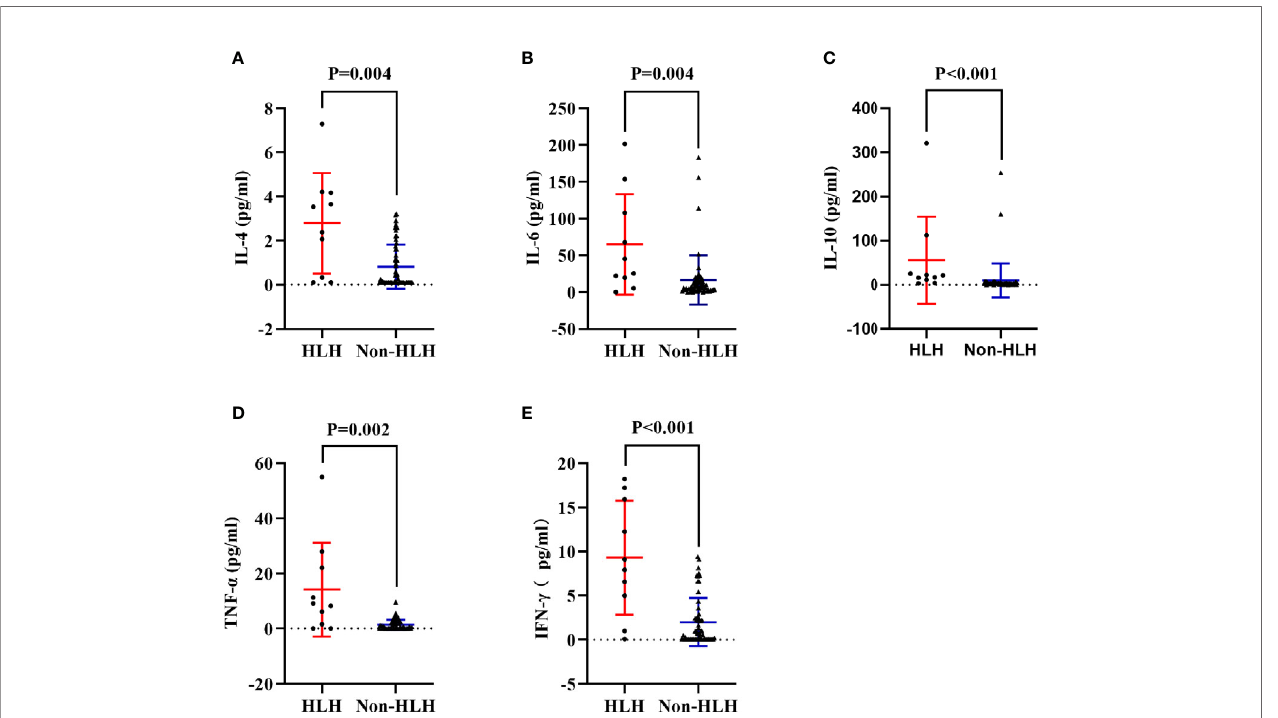
FIGURE 3 | Comparisons of cytokines in HLH and non-HLH groups. (A) Comparison of serum IL-4 between HLH and non-HLH groups. (B) Comparison of serum IL-6 between HLH and non-HLH groups. (C) Comparison of serum IL-10 between HLH and non-HLH groups. (D) Comparison of serum TNF- a between HLH and non-HLH groups. (E) Comparison of serum IFN- g between HLH and non-HLH groups. HLH, Hemophagocytic lymphohistiocytosis; IL, Interleukin; TNF,Tumor necrosis factor; IFN,